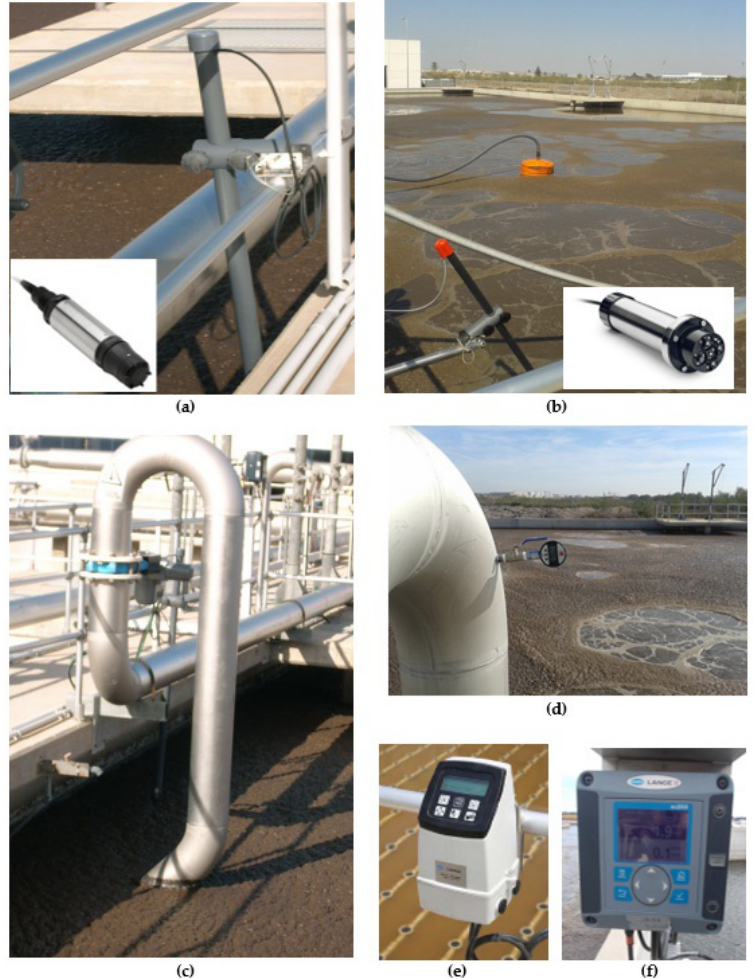
Figure 4. ( a ) Dissolved oxygen sensor; ( b ) combined ammonium and nitrate sensor; ( c ) motorized airline valve; ( d ) pressure transducer; and ( e , f ) dissolved oxygen and ammonium / nitrate controllers,